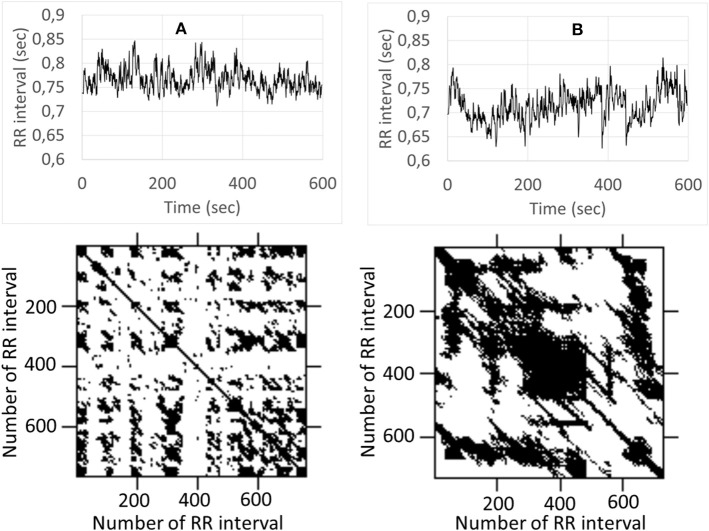
Examples of the RP and RR for rest (A) and mental stress (B). Upper parts of (A,B) depict variation of R-R intervals, the lower graphs demonstrate corresponding recurrence plot.